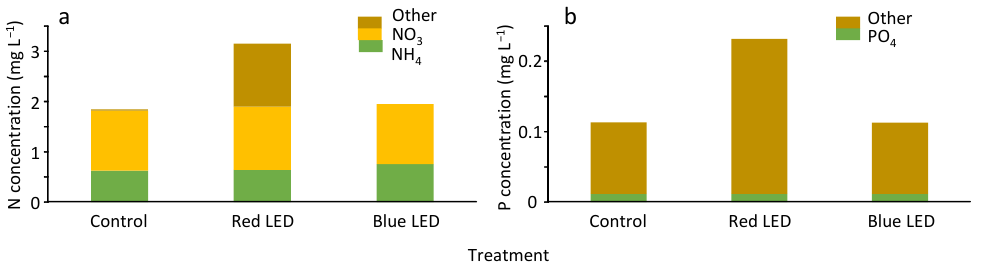
Figure 5. Nutrient concentrations (( a ): nitrogen, ( b ): phosphorus) in the depressions at the end of the experiment. Other shows the fraction other than the measured inorganic forms in TN/TP.